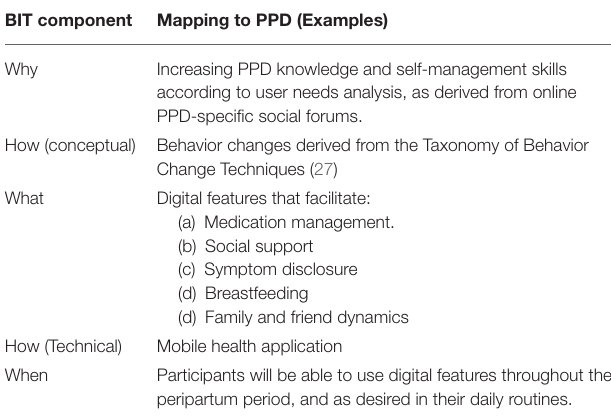
TABLE 4 | Linguistic characteristics of training dataset.